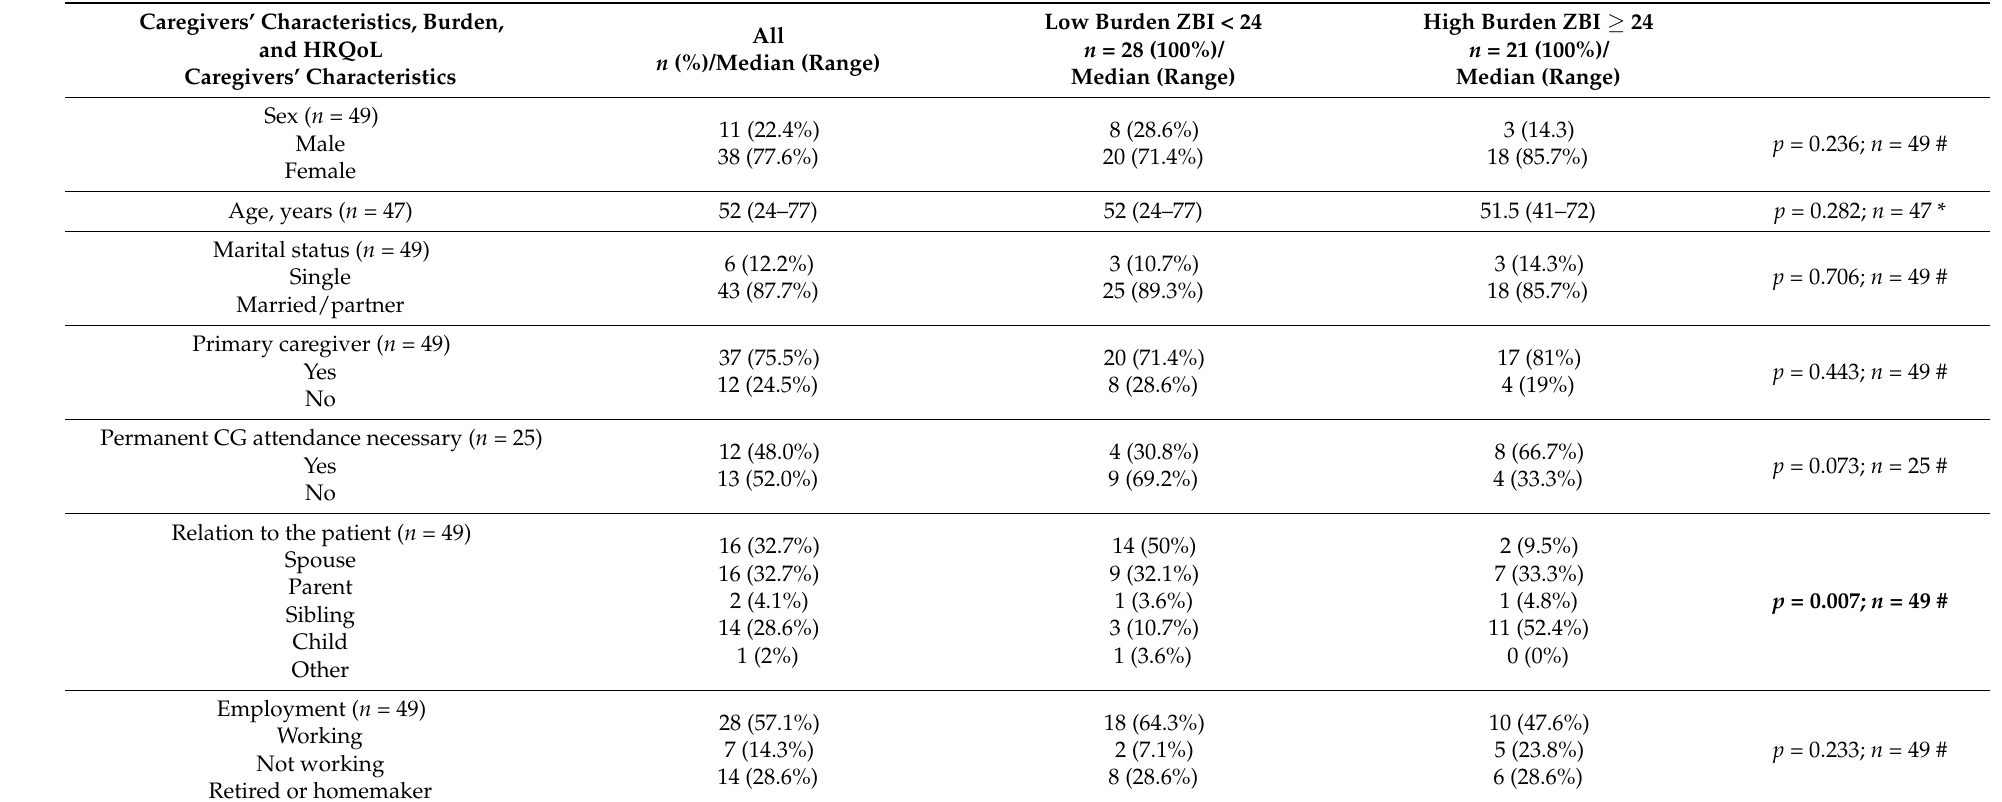
Table 3. Caregivers’ characteristics, burden and HRQoL. This table shows the demographic and clinical characteristics of the patient/caregiver pairs. The pairs were dichotomized into a high-burden group and a low-burden group according to the CG’s ZBI score (cut-off = 24). Statistical parameters printed in bold type indicate statistically significant differences between the high- and the low-burden groups. * indicates that a Mann–Whitney U Test was performed. # indicates that either chi-Square or Fisher’s exact tests were performed. Abbreviations: n = number; HRQoL = health-related quality of life; CG = caregiver; ZBI = Zarit Burden Interview; DOC = duration of care; HADS-D = Hospital Anxiety and Depression Scale—Depression Subscale; HADS-A = Hospital Anxiety and Depression